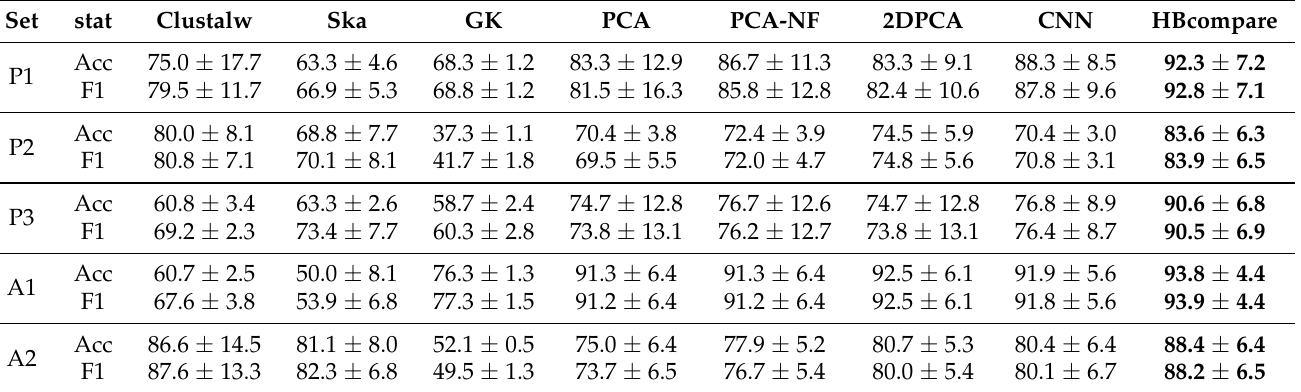
Table 4. Average classification accuracy and F1 score (avg ± std) using both hydrogen bond topology and coordinate information, across all folds. The set column indicates the dataset. The stat column indicates rows with either classifier accuracy or F1 score. The highest value in each row is bolded.